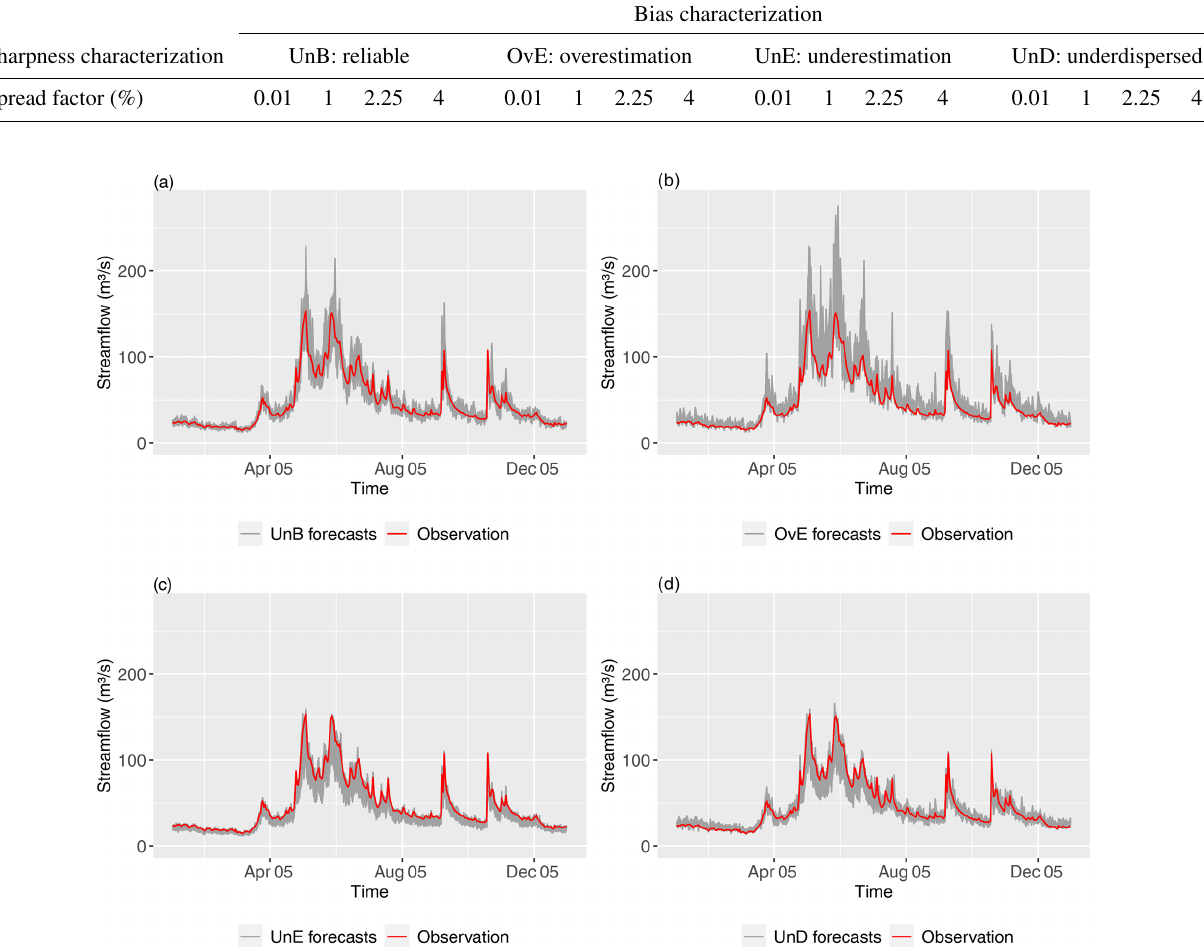
Figure 2. Illustration of the synthetic forecasts generated: (a) UnB (reliable and unbiased forecasts), (b) OvE (forecasts that overestimate), (c) UnE (forecasts that underestimate) and (d) UnD (underdispersed forecasts). The example is for catchment 1 (Fig. 1) and the 1d forecasts of 2005. The spread factor used for this figure is